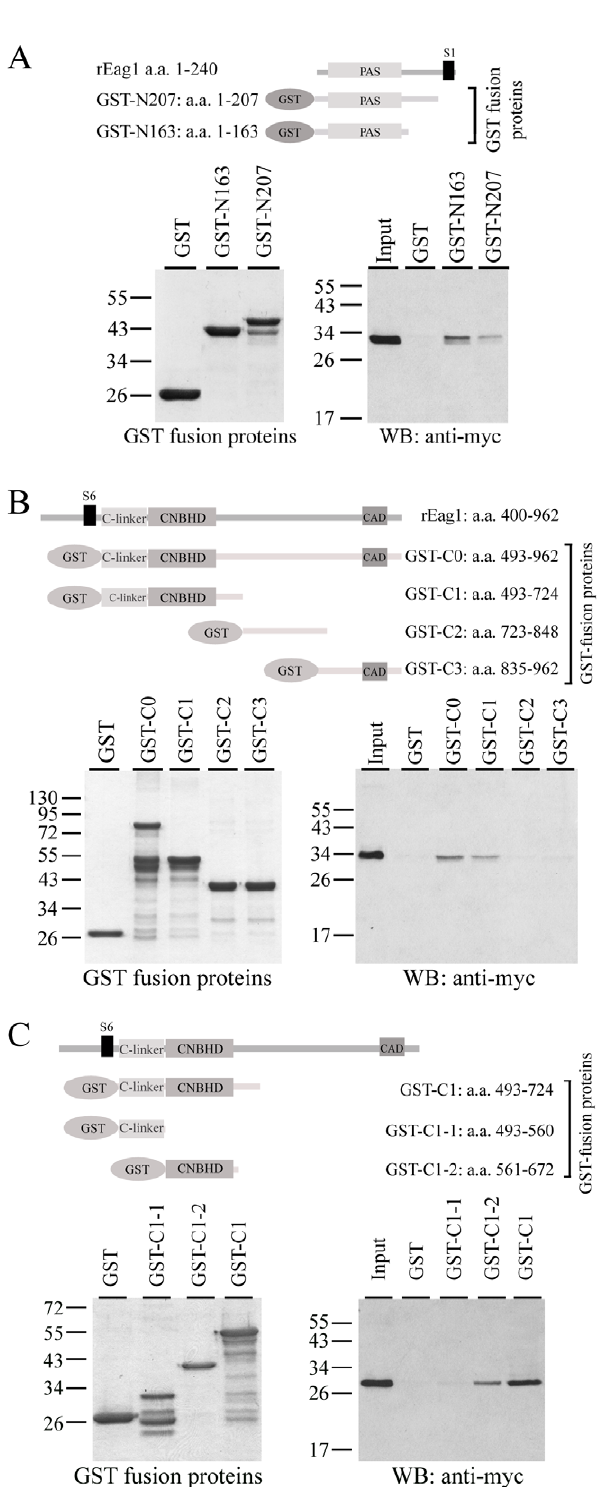
Figure 3. The contribution of PAS and CNBHD to rEag1 interaction with 14-3-3 h . GST pull-down assays of rEag1 N-terminal and C-terminal GST fusion proteins containing specific structural domains. ( Upper panels ) Schematic representation of the rEag1 N- terminal ( A ) or C-terminal ( B,C ) GST fusion proteins. ( Lower left panels ) Coomassie blue staining of the GST proteins. ( Lower right panels ) Immunoblotting of pull-down products with the anti-myc antibody.